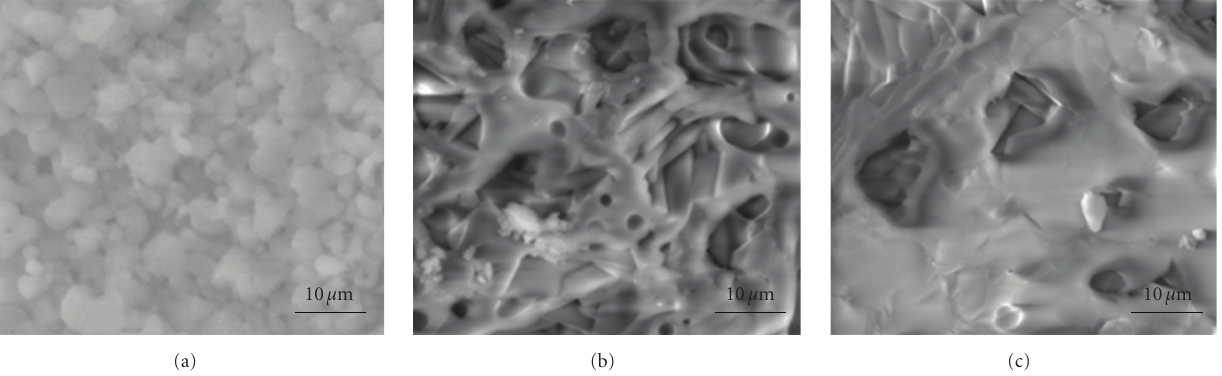
Figure 11: SEM micrographs of M x FA samples sintered at 1200 ◦ C for 1h: (a) x = 0, (b) x = 1, and (c) x = 2.